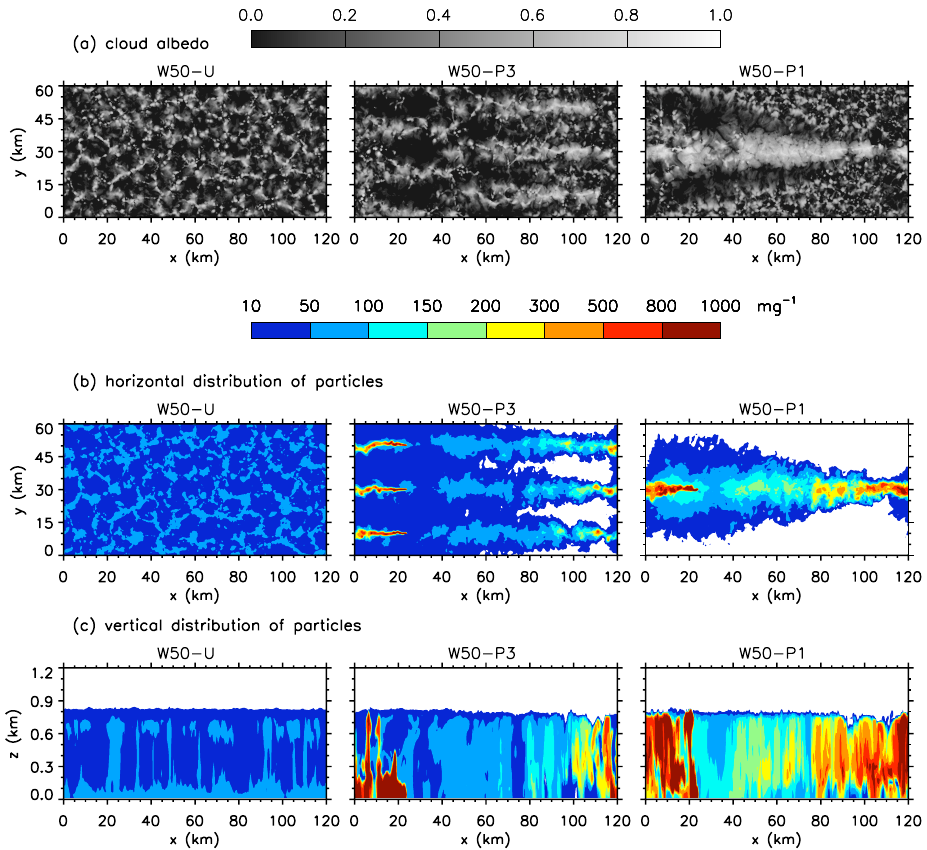
Fig. 1. Snapshot of (a) cloud albedo, (b) boundary-layer mean number concentration of injected particles on the x - y plane, and (c) particle number concentration on a x - z cross section at y =30km (track of the central sprayer) at t =8h when sprayers are at x =24km on their second journey. Particles in the plots are passive tracers providing a measure of the maximum extent of mixing resulting from the particle